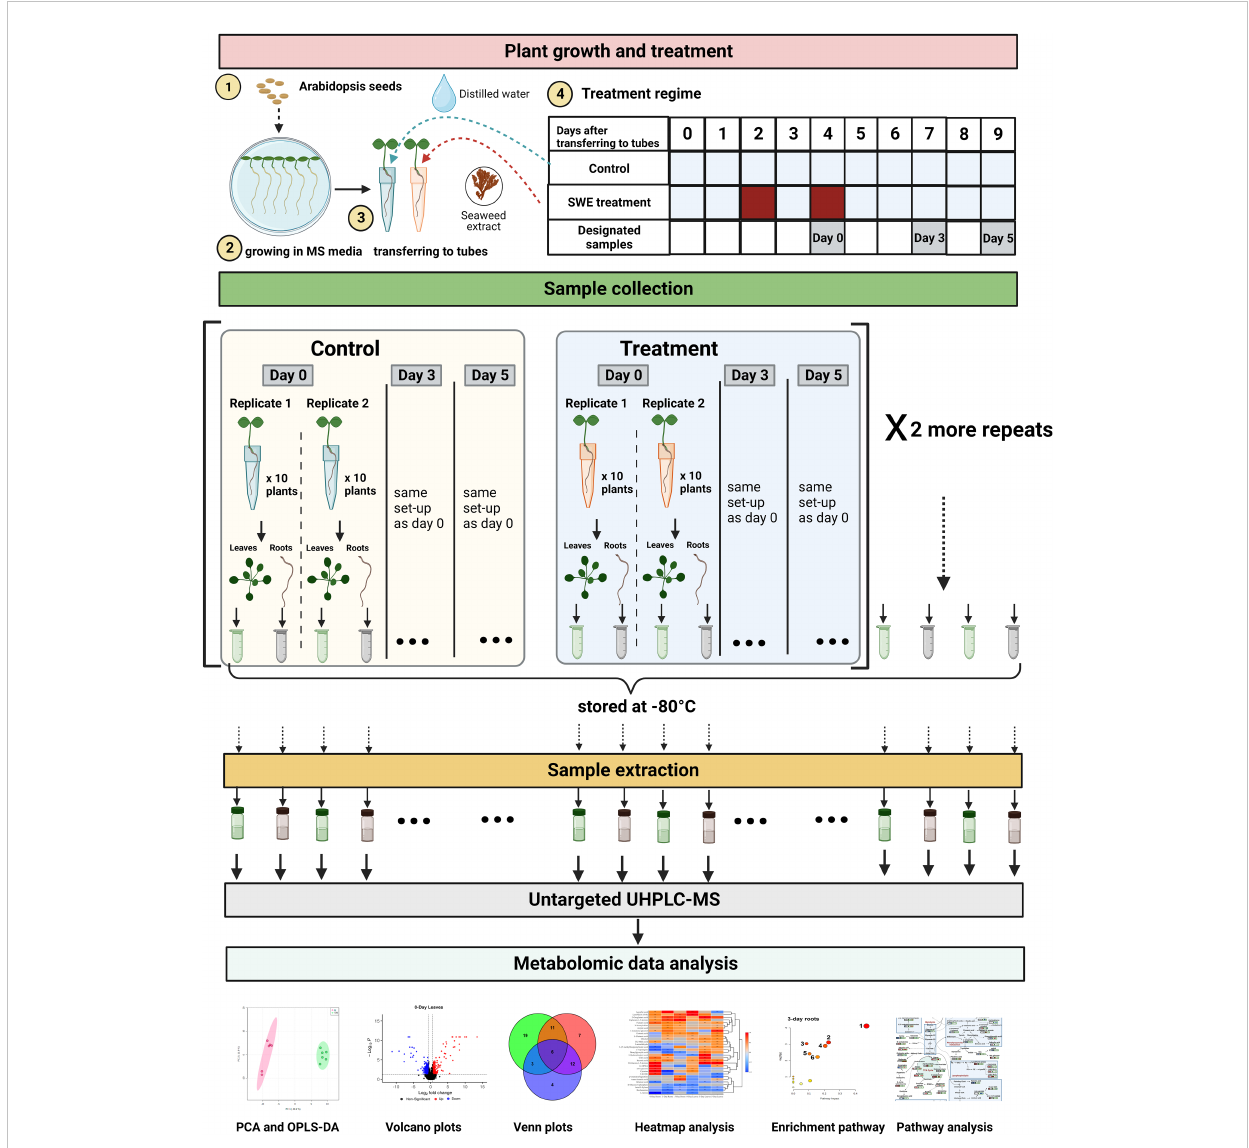
MS/MS data with a mass tolerance window at 5 ppm. The metabolite identi fi cation was undertaken by searching against in- house and online databases, including: Mass List; ChemSpider (http://www.chemspider.com) used MS data (molecular weight